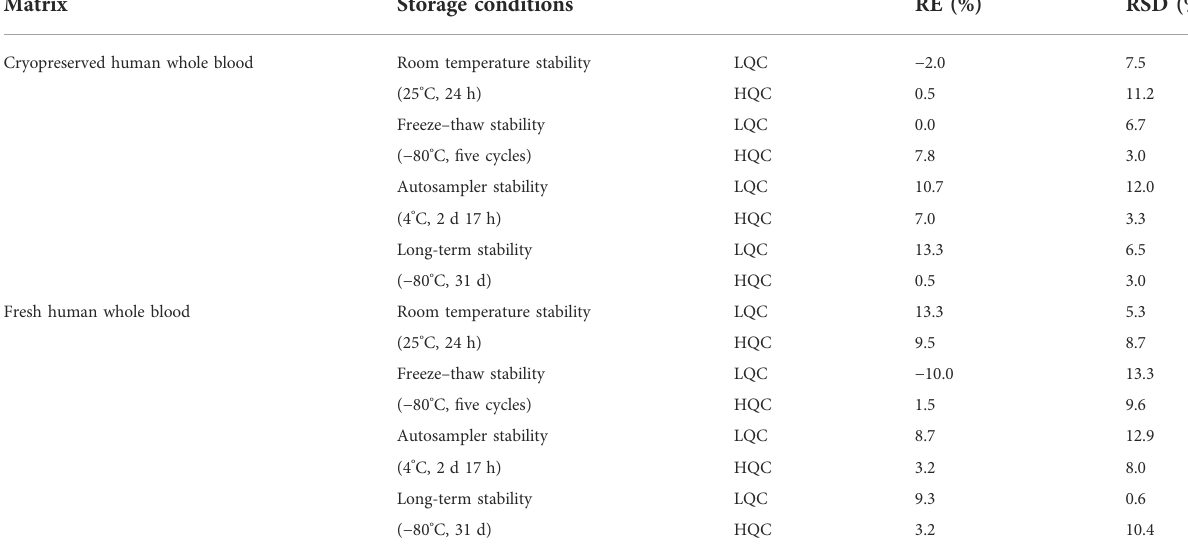
TABLE 5 Stability of SRL in cryopreserved and fresh human whole blood ( n = 3).